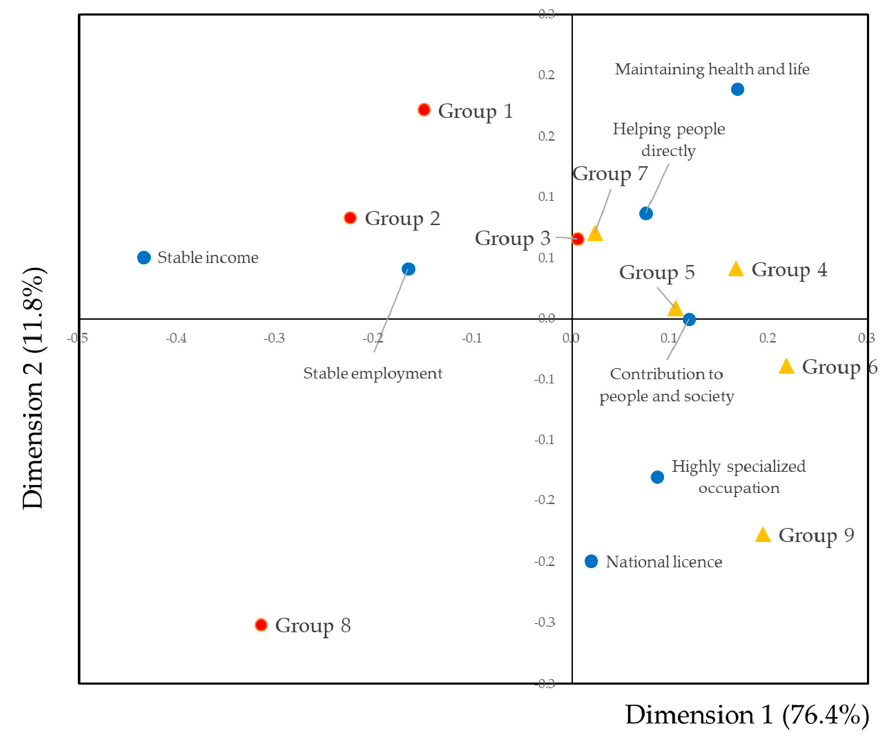
Figure 4. Biplot of groups by daily tasks and the attractiveness of dental hygienists’ work. Blue circles indicate the attractiveness of dental hygienists’ work. Red squares indicate groups in which the proportion of full-time workers were high. Yellow triangles indicate groups in which the proportion of part-time workers were high. The contribution ratio of dimension 1 was 76.4% and that of dimension 2 was 11.8%.